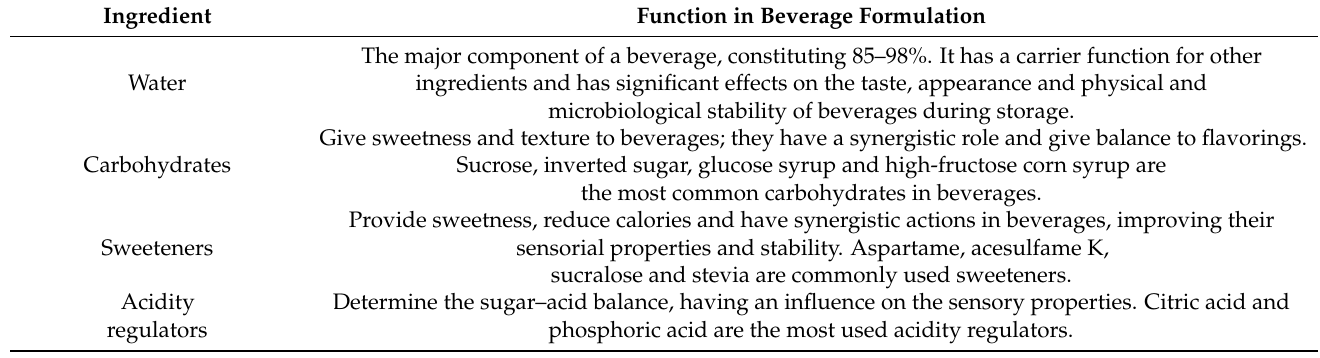
Table 1. Principal ingredients in beverage formulation